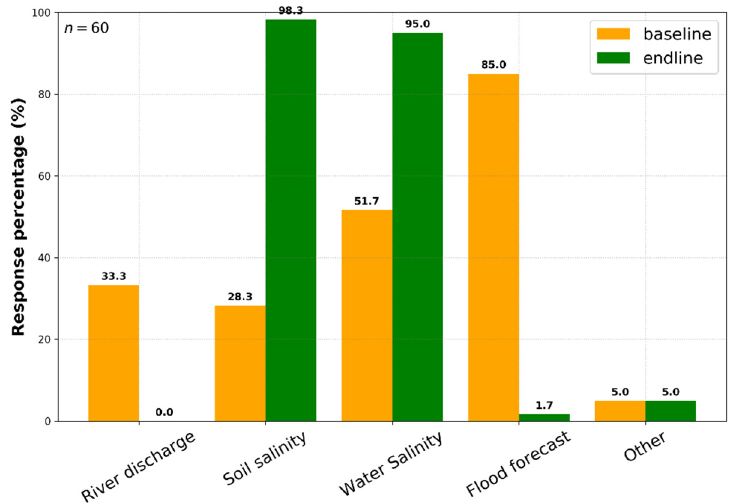
Figure 5. Baseline versus endline water information needs of periurban farmers in the Lower Bengal Delta.